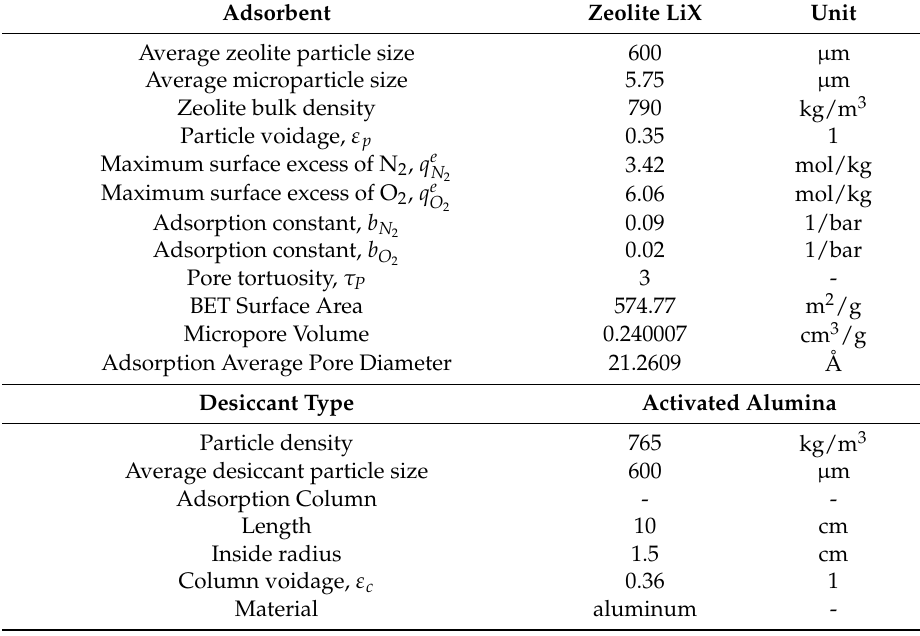
Table 3. Characteristics of adsorbent, desiccant and adsorption column [17,22–25]. Adsorbent Zeolite